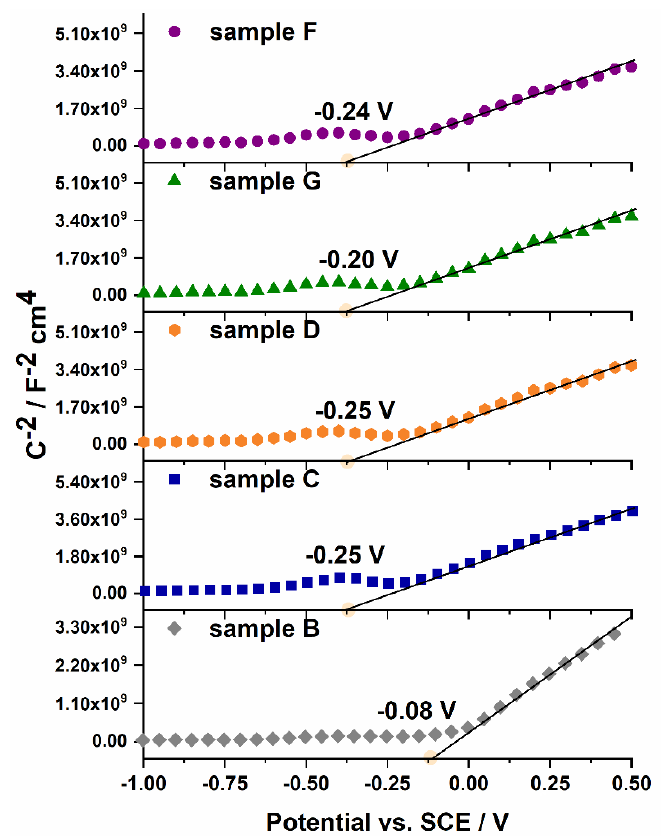
Figure 6. Mott-Schottky analyses performed at 1000 Hz in 0.1 M KNO 3 electrolyte measured for all tested anodic WO 3 samples.